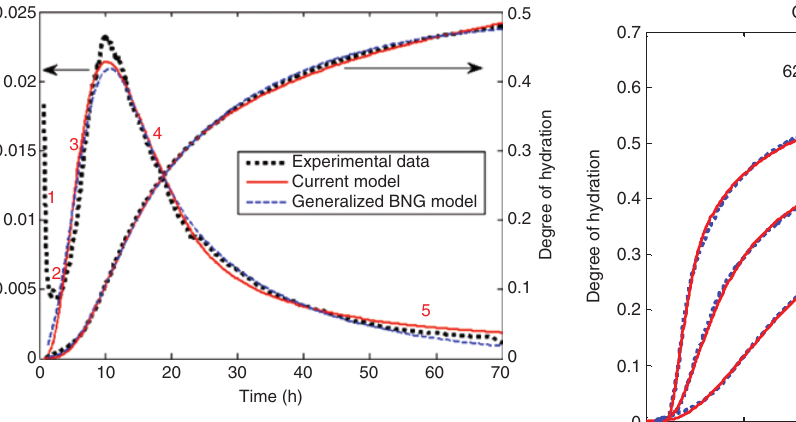
Figure 3: Model fits to experimental data of Test H-1.